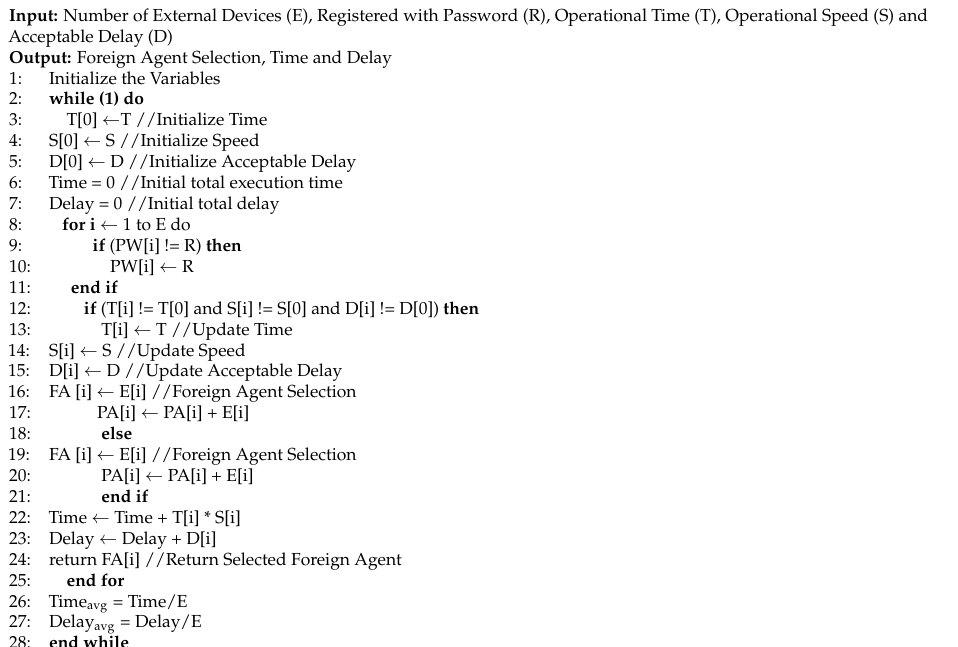
Algorithm 1: Proposed Foreign Agent Selection